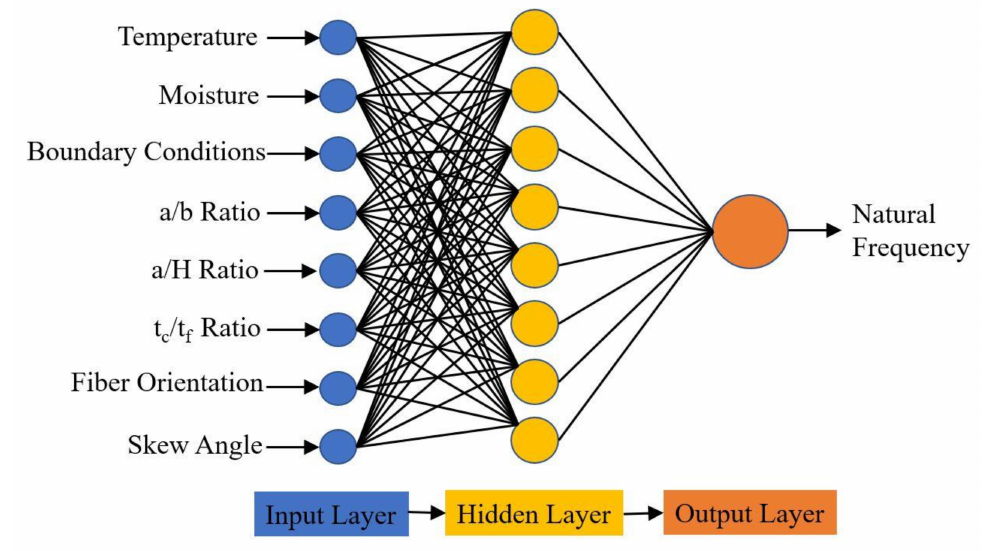
Figure 3. The architecture of the proposed ANN prediction model. The data were divided into 70% for training, 15% for validation, and 15% for testing. The Levenberg–Marquardt algorithm was used to train the network. The trial-and-error method was used to find the optimum number of neurons to model the network archi- tecture with eight inputs and one output. From Figure 4, it is evident that the ANN architecture with a single layer and eight neurons is an optimal option as it has the mini- mum mean square error (MSE) and maximum correction coefficient (R) value, i.e., 1.2667 and 0.9924, respectively.